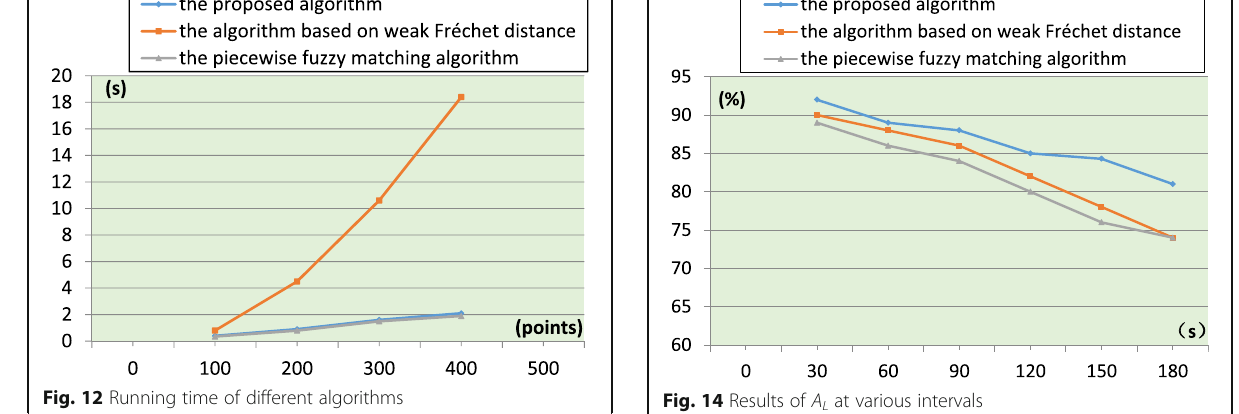
Fig. 14 Results of A L at various